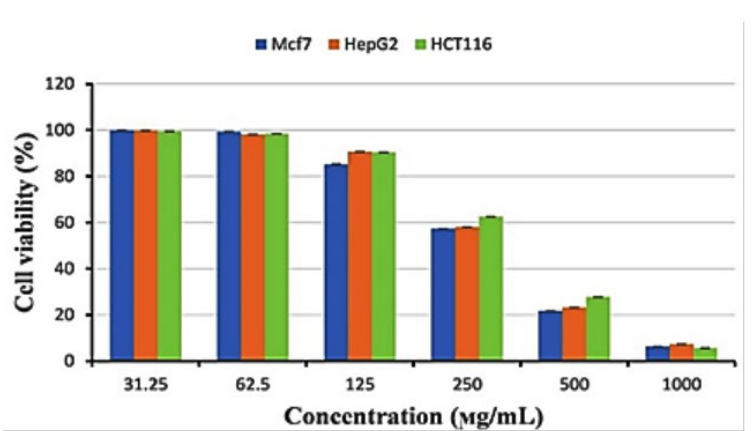
Fig. 6. Phylogenetic tree based on 16S rRNA sequences using neighbor joining method showing relationships between the selected M3 isolate isolated from mangrove habitat and their closely related type strains